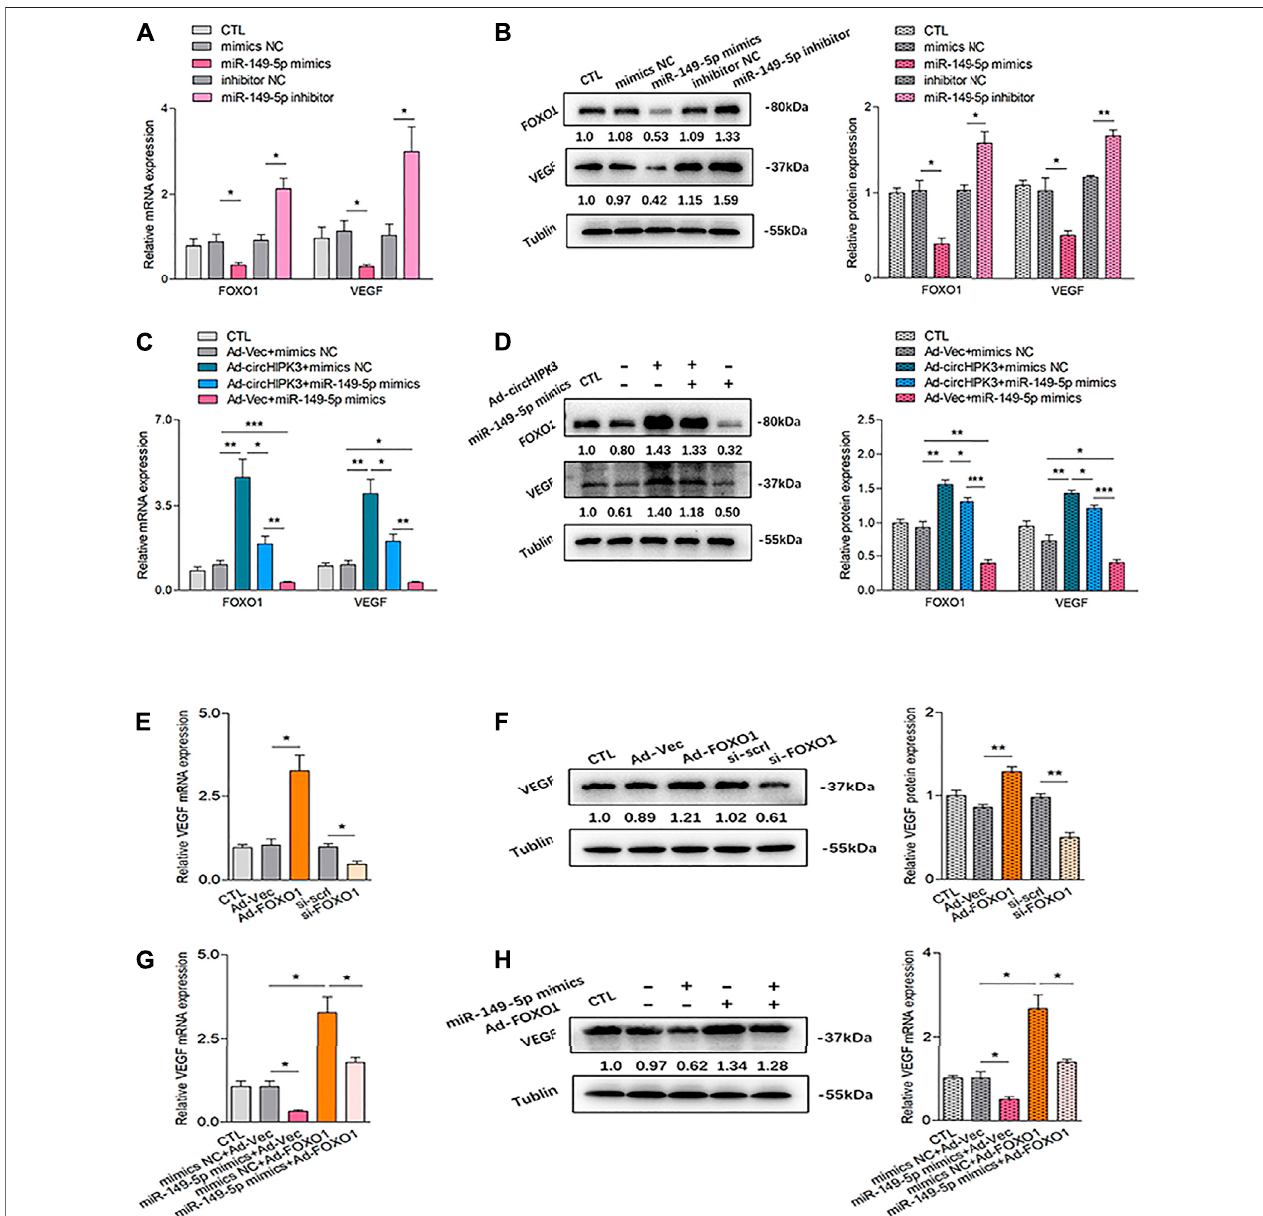
FIGURE 3 | Con fi rmation of the circHIPK3/miR-149-5p/FOXO1/VEGF functional module in vitro . (A – B) FOXO1/VEGF mRNA (A) and protein expression (B) were obviously down-/up-regulated by miR-149-5p mimics/inhibitor (n (cid:1) 3; * p < 0.05, ** p < 0.01). (C – D) Co-effects of circHIPK3 and miR-149-5p on FOXO1/VEGF expressioninRA-FLSwereevaluated.FOXO1/VEGFmRNA (C) andprotein. (D) Theexpressionsweresigni fi cantlyelevated/reducedbycircHIPK3overexpression/miR- 149-5p mimics compared with those of each control group. Moreover, the signi fi cant downregulation of FOXO1/VEGF expression repressed by miR-149-5p mimics could be obviously rescued by circHIPK3 overexpression; in other words, the signi fi cant upregulation of FOXO1/VEGF expression induced by circHIPK3 overexpressioncouldbesigni fi cantlyinhibitedbymiR-149-5pmimics(n (cid:1) 3;* p < 0.05,** p < 0.01,*** p < 0.001). (E – F) ThemRNA (E) andprotein (F) expressionofVEGF in RA-FLS were signi fi cantly elevated/reduced by FOXO1 overexpression/knockdown (n (cid:1) 3; * p < 0.05, ** p < 0.01). (G – H) FOXO1 overexpression signi fi cantly upregulated VEGF mRNA (G) and protein (H) expression, and the increment of VEGF expression induced by FOXO1 overexpression could be signi fi cantly suppressed by miR-149-5p mimics (n (cid:1) 3; * p < 0.05). Results are expressed as the mean ± S.E.M. CTL (cid:1) PBS control group. si-scrl (cid:1) scramble siRNA. NC (cid:1) negative control.